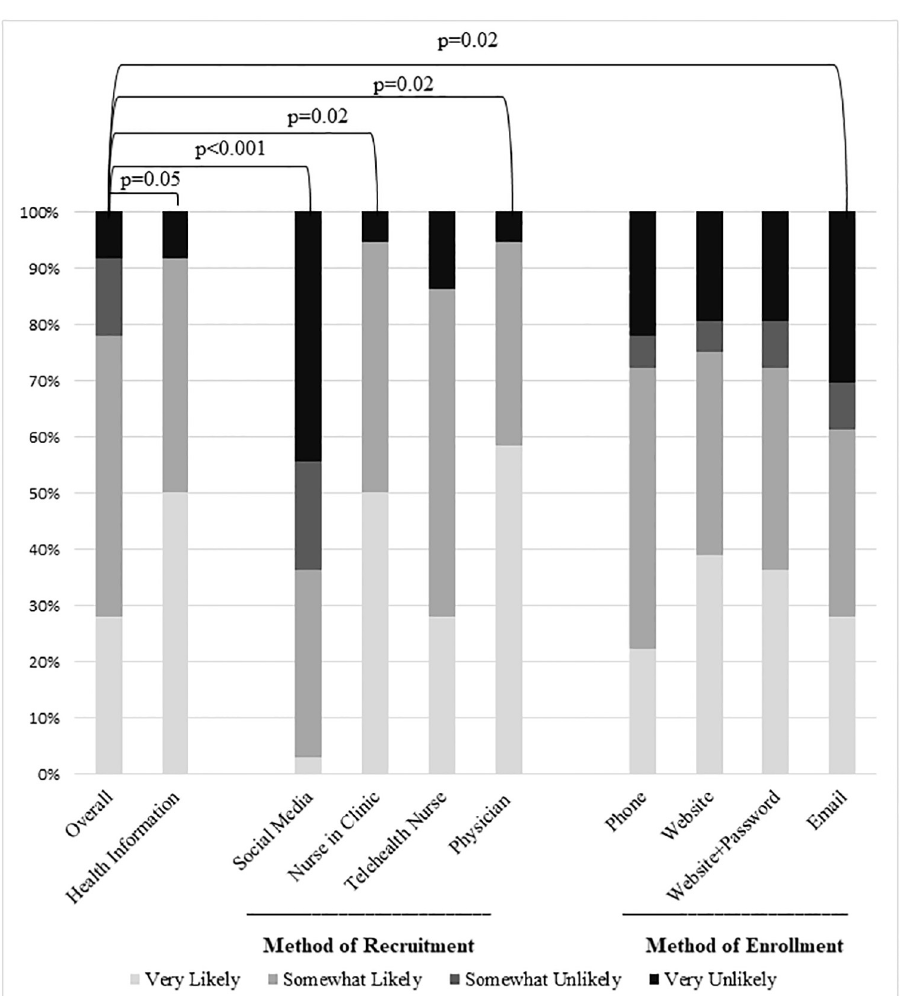
Fig 1. Differences in participant likelihood to enroll their child in a PPRR based on whether they received information on pediatric health as a benefit of enrollment, method of recruitment, and method of enrollment (N =